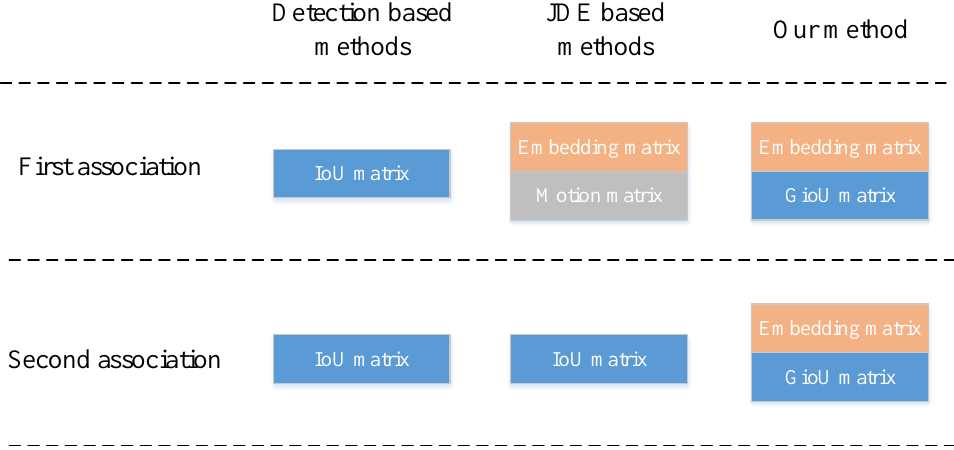
Figure 2. Association matrices used in cascade matching of different tracking